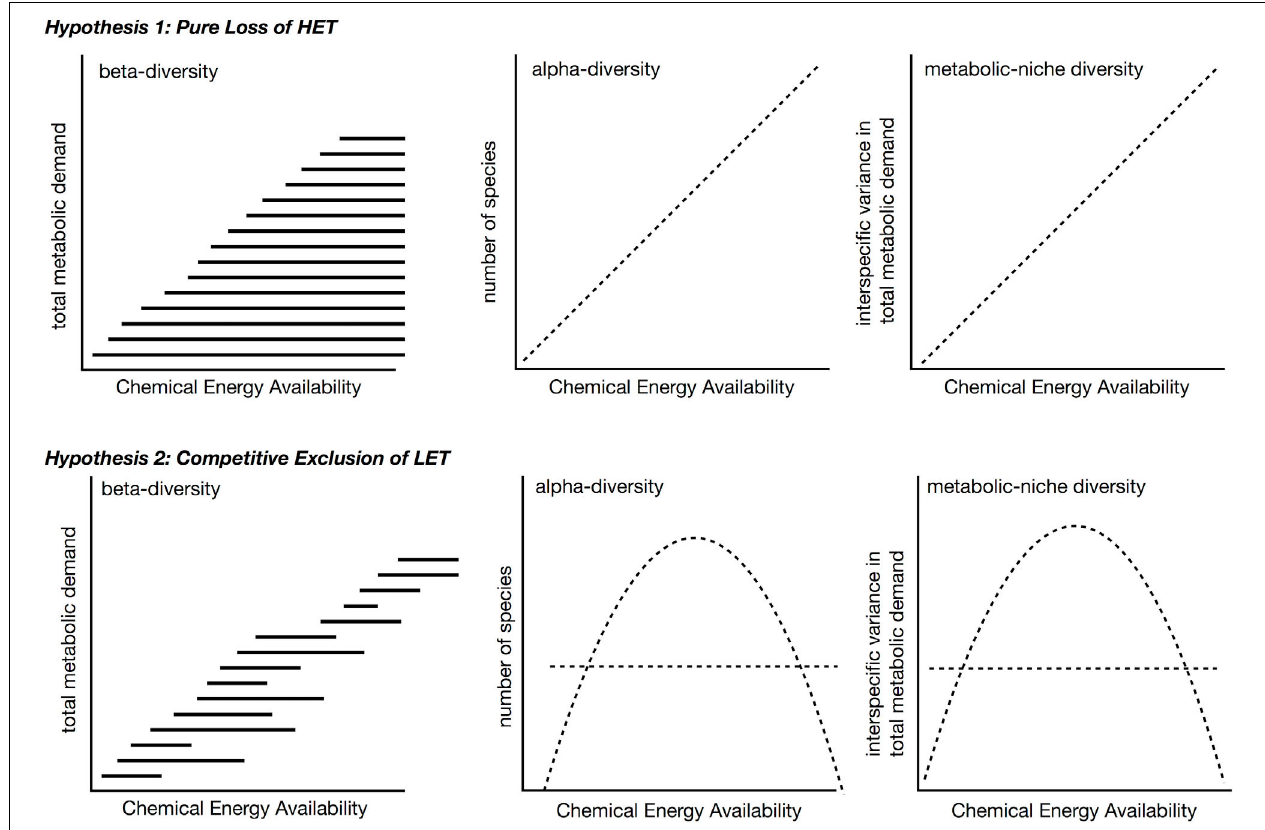
FIGURE 8 | Two hypotheses for beta- and alpha-diversity patterns in the context of metabolic niches. In both scenarios, high energy taxa (HET) are lost from communities as chemical energy availability decreases across a gradient. In the second hypothesis, high chemical energy availability LET are additionally outcompeted, e.g., due to slower populations rates, and are lost from these communities. The competitive exclusion in LET in second hypothesis leads to a unimodal species-energy relationship as opposed to a linear pattern. In both hypotheses, metabolic niche diversity, e.g., interspecific variation in metabolic rate, should mirror the species richness